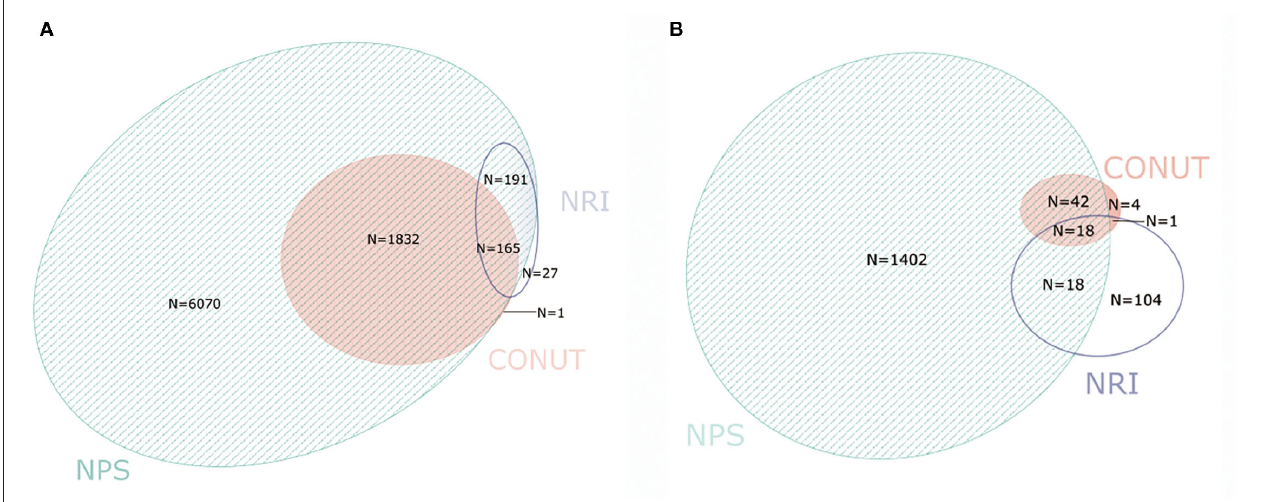
FIGURE 2 | Venn diagram. The numbers in circles indicate the cumulative frequency of malnutrition [any degree (A) vs. moderate-severe (B) ] according to each malnutrition screening tool. The overlapping area of the circles indicate the patient which diagnosed with malnutrition by more than one malnutrition screening tool. CONUT, Controlling Nutritional Status score; NRI, Nutritional Risk Index; NPS, Naples Prognostic Score.